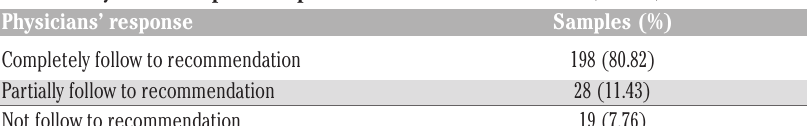
Table 6. Physicians’ response to pharmacists’ recommendations